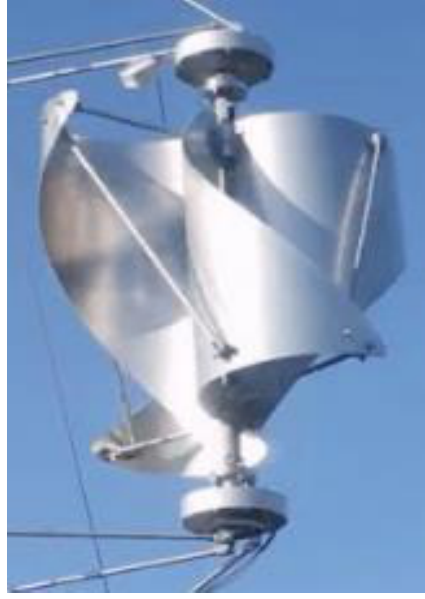
Figure 2. RW IceWind turbine.